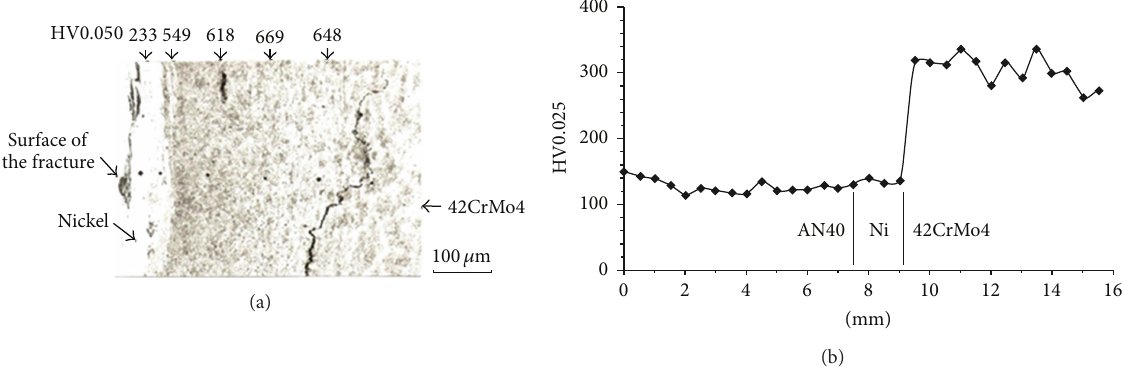
Figure 22: The friction welded 42CrMo4 steel-AN40 alloy joints, microstructure after the tensile test (a), and a microhardness pattern (b) (according to